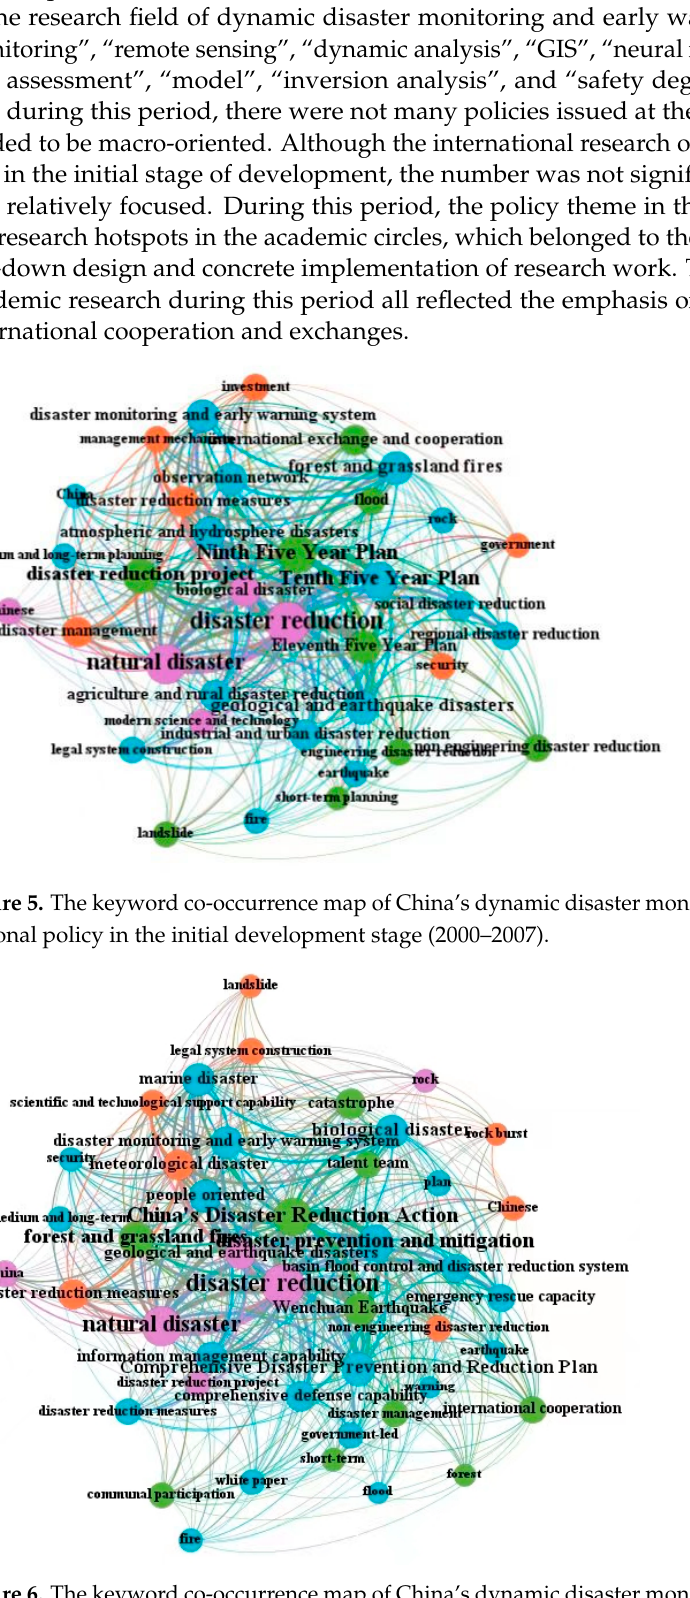
Figure 6. The keyword co-occurrence map of China’s dynamic disaster monitoring and early warning national policy in the rising development stage (2008–2015).